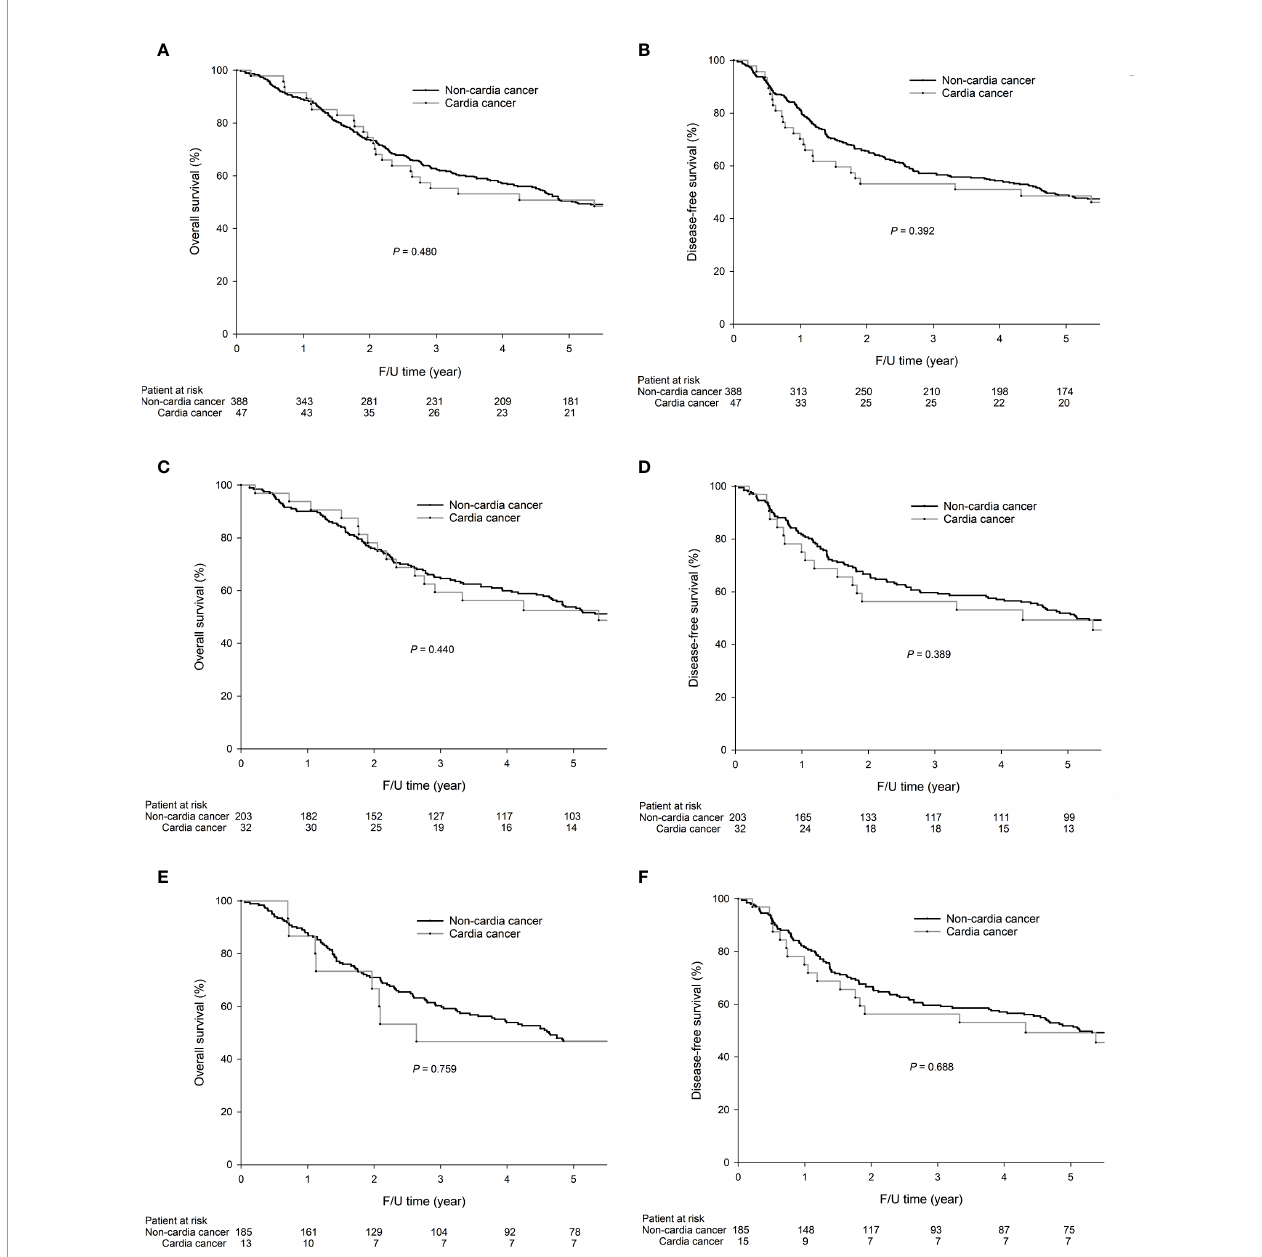
FIGURE 1 | The 5-year OS (50.8% vs. 50.5%, P = 0.480) and DFS (48.6% vs. 48.9%, P = 0.392) rates were not signi fi cantly different between cardia and noncardia GC. For intestinal-type GC patients, the 5-year OS (53.8% vs. 52.5%, P = 0.440) and DFS (49.3% vs. 51.9%, P = 0.389) rates were not signi fi cantly different between cardia and noncardia GC. For diffuse-type GC patients, the 5-year OS (46.7% vs. 46.8%, P = 0.759) and DFS (46.7% vs. 45.4%, P = 0.688) rates were not signi fi cantly different between cardia and noncardia GC. The survival curves are shown as follows: (A) OS curves of all GC patients; (B) DFS curves of all patients; (C) OS curves of intestinal-type GC patients; (D) DFS curves of intestinal-type GC patients; (E) OS curves of diffuse-type GC patients; (F) DFS curves of diffuse-type GC